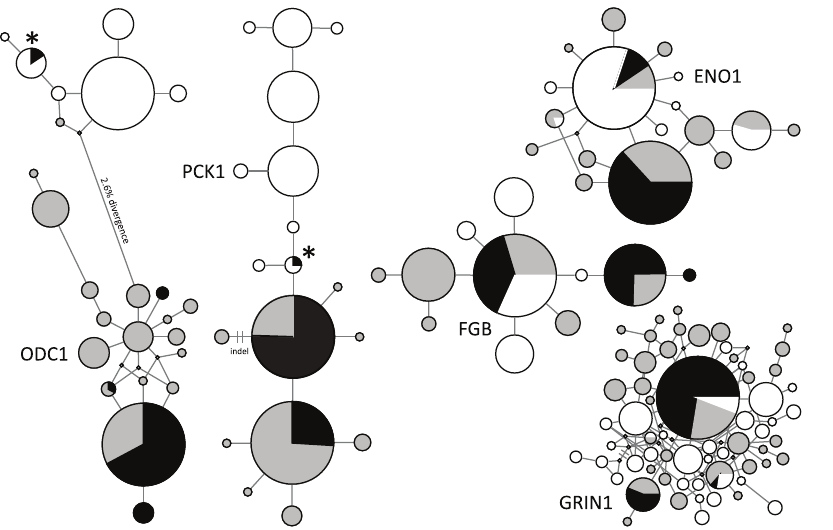
Figure 2. Networks for five nuclear loci sequenced from pintails and speckled teal. Alleles sampled from South Georgia pintails are illustrated in black, and alleles sampled from yellow-billed pintails in Argentina are illustrated in gray. Alleles samples from speckled teal are shown in white. Circle area is proportional to the total number of alleles.